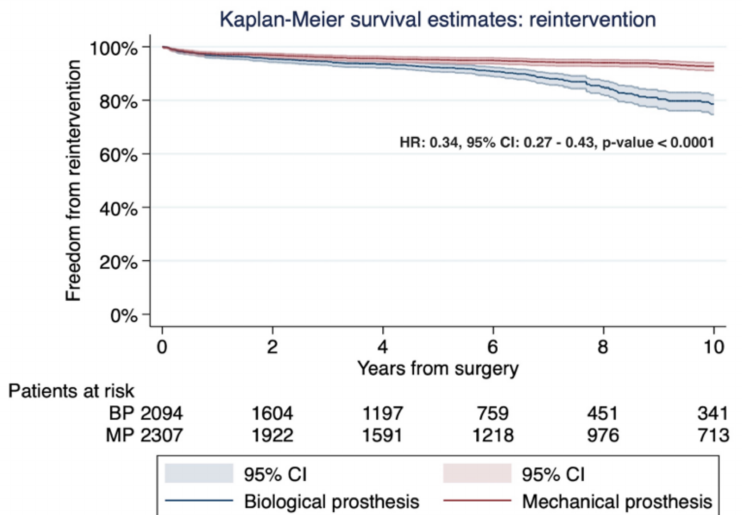
Figure 11. Kaplan–Meier curves detailing the freedom from prosthesis reintervention. The MP group is associated with a lower risk of reintervention compared to the BP group. The log-rank test was statistically significant, favoring the MP group ( p < 0.0001). Abbreviations: HR, hazard ratio; CI, confidence interval; MP, mechanical prosthesis; and BP, biological